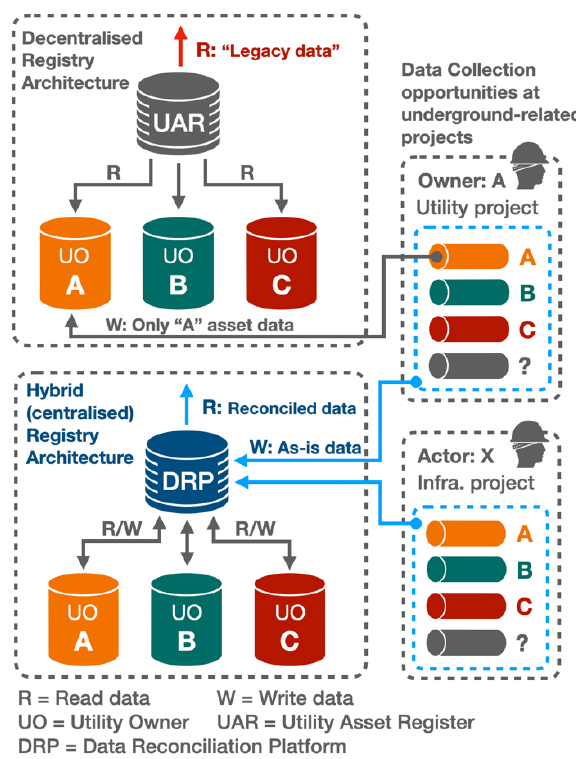
Figure 7 . Traditional decentralised-based Utility Asset Register (top part) compared to a centralised-inspired approach (bottom part) that integrates a Data Reconciliation Platform to reconcile sourced Utility Owner data with new captured as-is